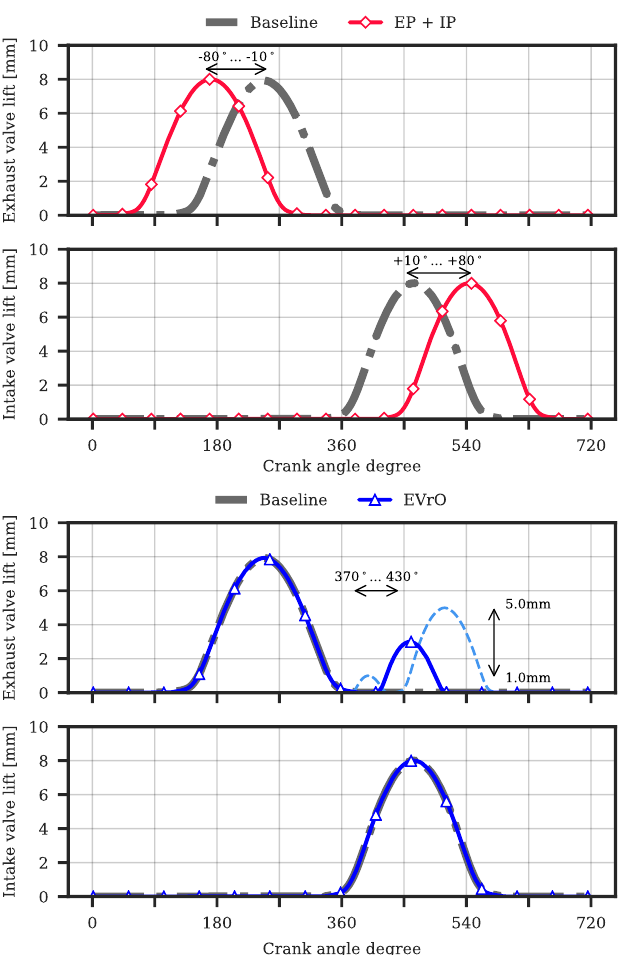
Figure 7. Exhaust and intake valve lift profiles for each case.